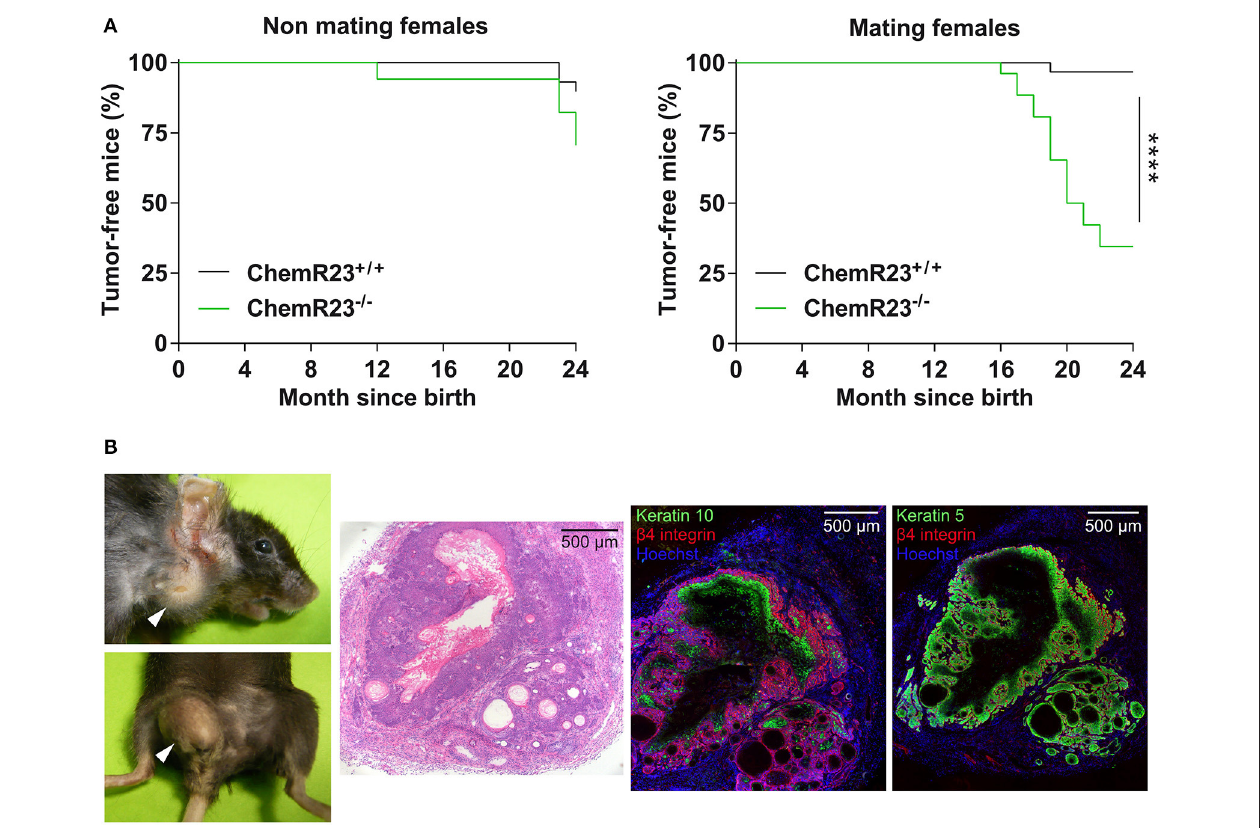
FIGURE 1 | Mice invalidated for ChemR23 develop spontaneous skin tumors. (A) Kaplan-Meyer plots representing the percentage of tumor-free mice in cohorts of control and ChemR23 − / − female mice kept chronically (right panel, n = 30 and 25 for respectively, controls and ChemR23 − / − ) or not (left panel, n = 26 and 17 for respectively controls and ChemR23 − / − ) in conditions of mating. The data are analyzed by Log-rank test. **** P < 0.0001. (B) Spontaneous skin tumors located in the neck and perineal regions of aged ChemR23 − / − female mice (left panels). White arrowheads indicate the location of tumors. Hematoxylin-eosin staining and immunostaining of keratin 10, keratin 5, and β 4 integrin in a spontaneous skin tumor (right